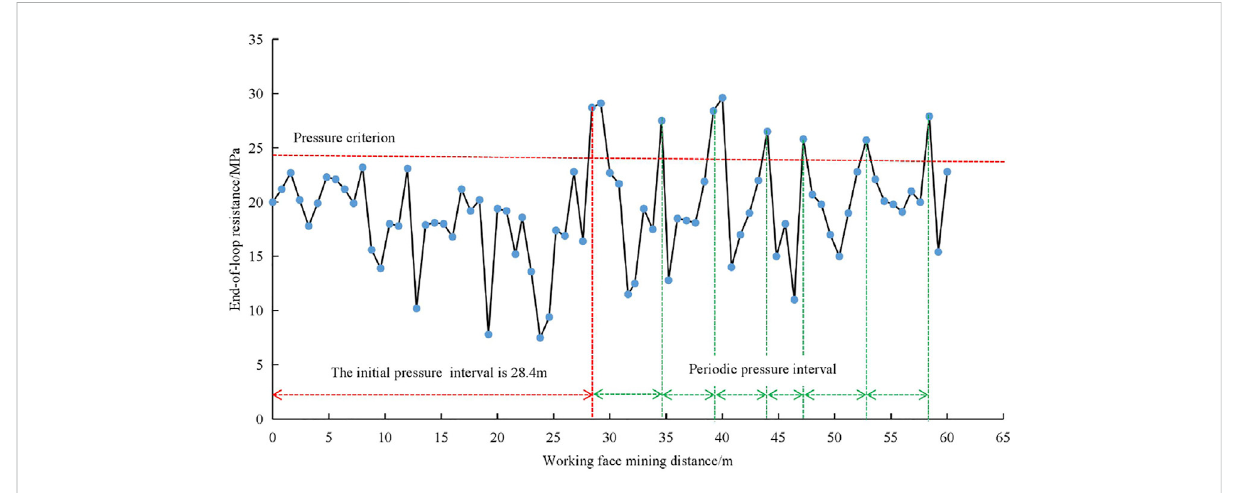
FIGURE 8 Curve of the end-of-loop resistance of the No. 15 hydraulic